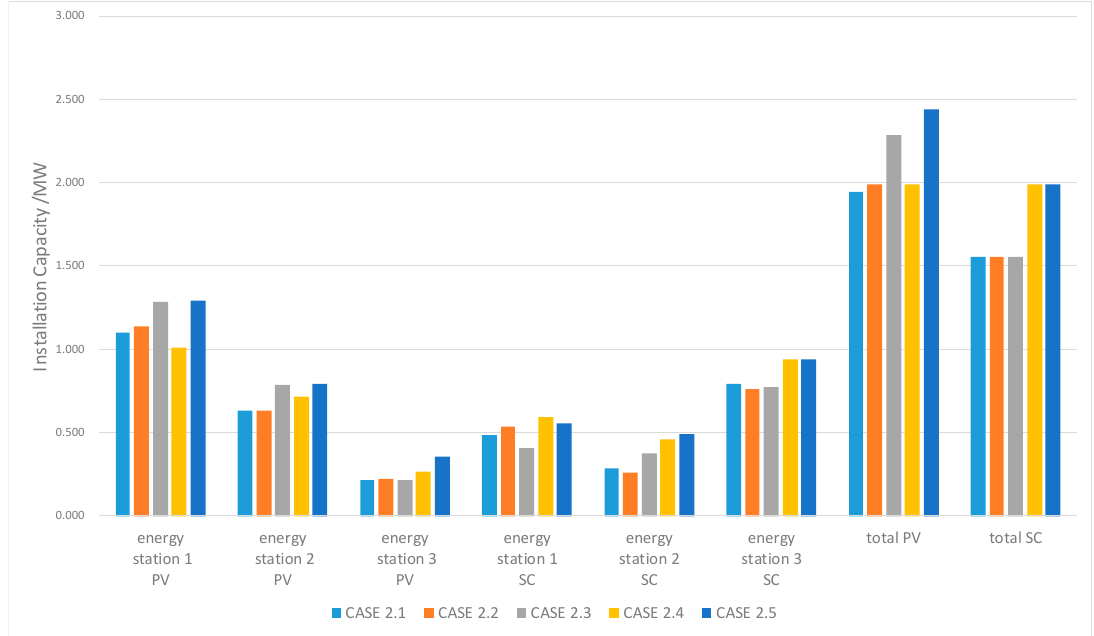
Figure 11. Results of the 24-h period cases.